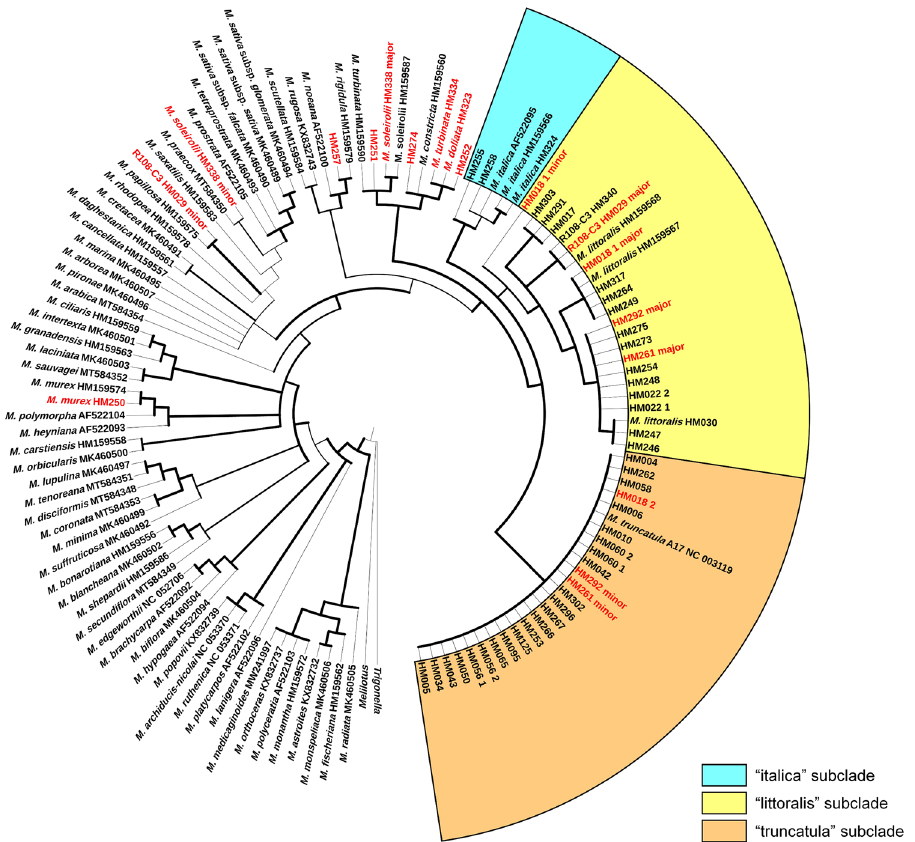
Figure 2. Maximum likelihood phylogeny of Medicago based on sequences of trnK/matK from Medicago ( M. ) species and two outgroup taxa. Members of the three subclades of the TLI clade are shaded with different colors. The wider branch width represents those lineages with higher bootstrap support values for each node. HapMap sequences placed outside the TLI clade or showing conflicting phylogenetic signals within a single NGS data or between first and second data from the same accession are indicated with red